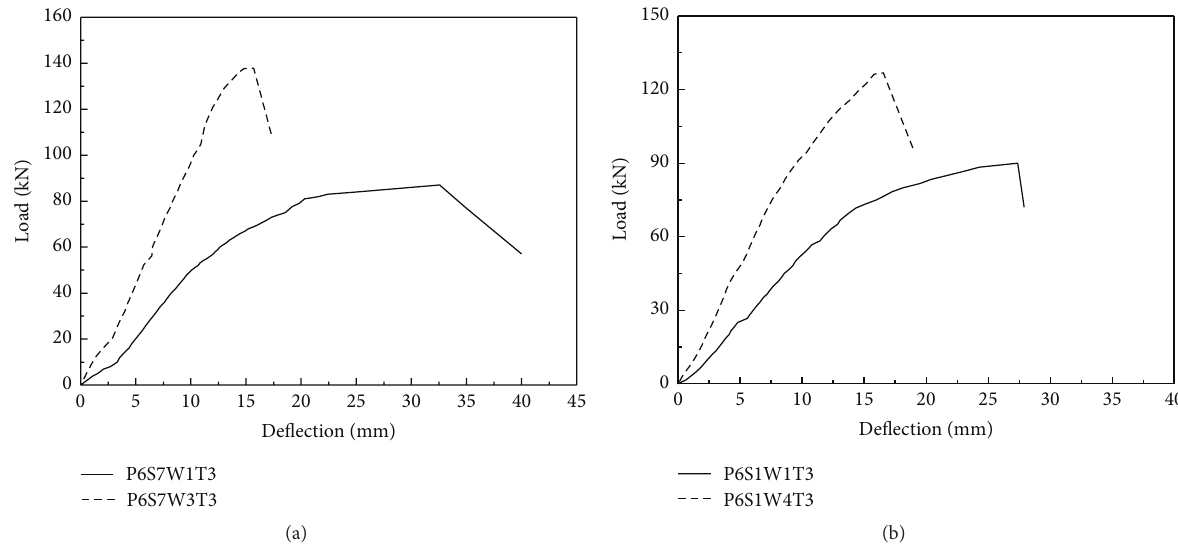
Figure 8: The influence of web thickness: (a) 𝑡 𝑠 = 3.2 mm, 𝑠 = 75 mm, and 𝜌 = 60 kg/m 3 and (b) 𝑡 𝑠 = 3.2 mm, 𝑠 = 125mm, and 𝜌 = 60 kg/m 3 .